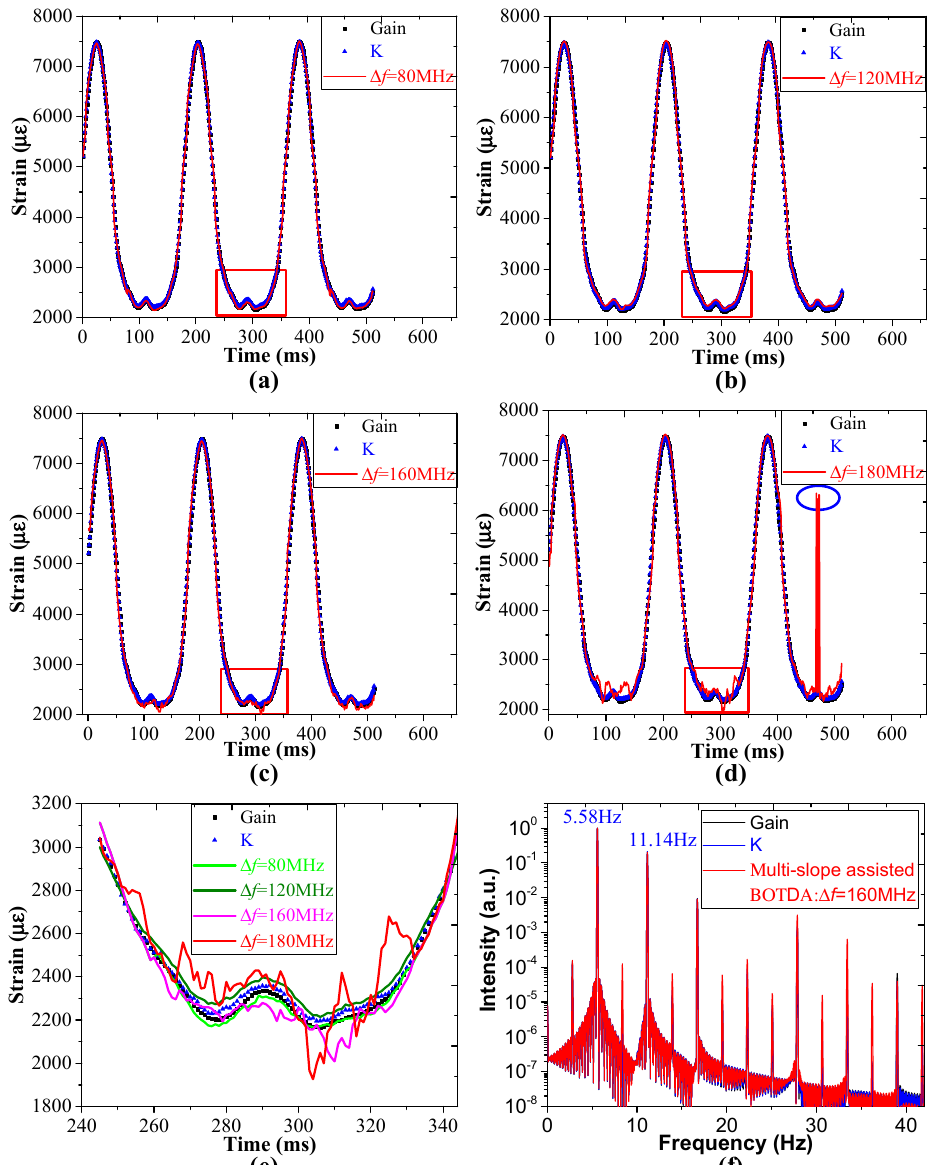
Figure 13. The experimental results of the dynamic strain measurement using the multi-slope-assisted BOTDA based on the KS and the OFA [11]. The time traces for frequency intervals of ( a ) 80 MHz, ( b ) 120 MHz, ( c ) 160 MHz, and ( d ) 180 MHz. The reference time traces (the black and blue dots) are calculated by curve-fitting the BGS and KS. ( e ) A zoom-in view of the time traces within the red blocks. ( f ) The power spectra at the frequency interval of 160 MHz.